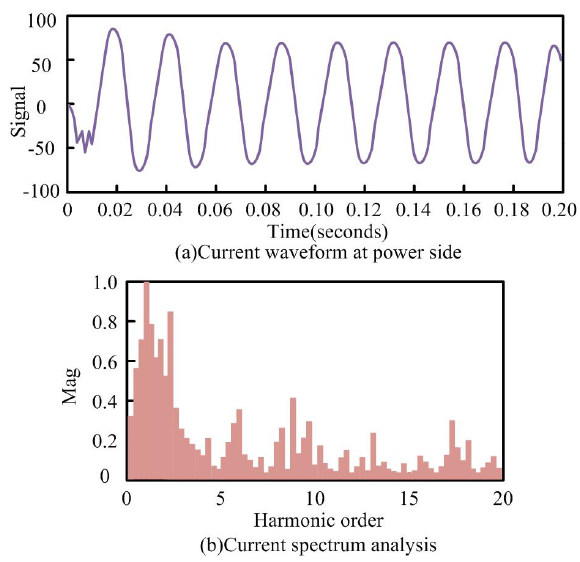
Fig. 9. Analysis of power supply current waveform and current spectrum under voltage distortion